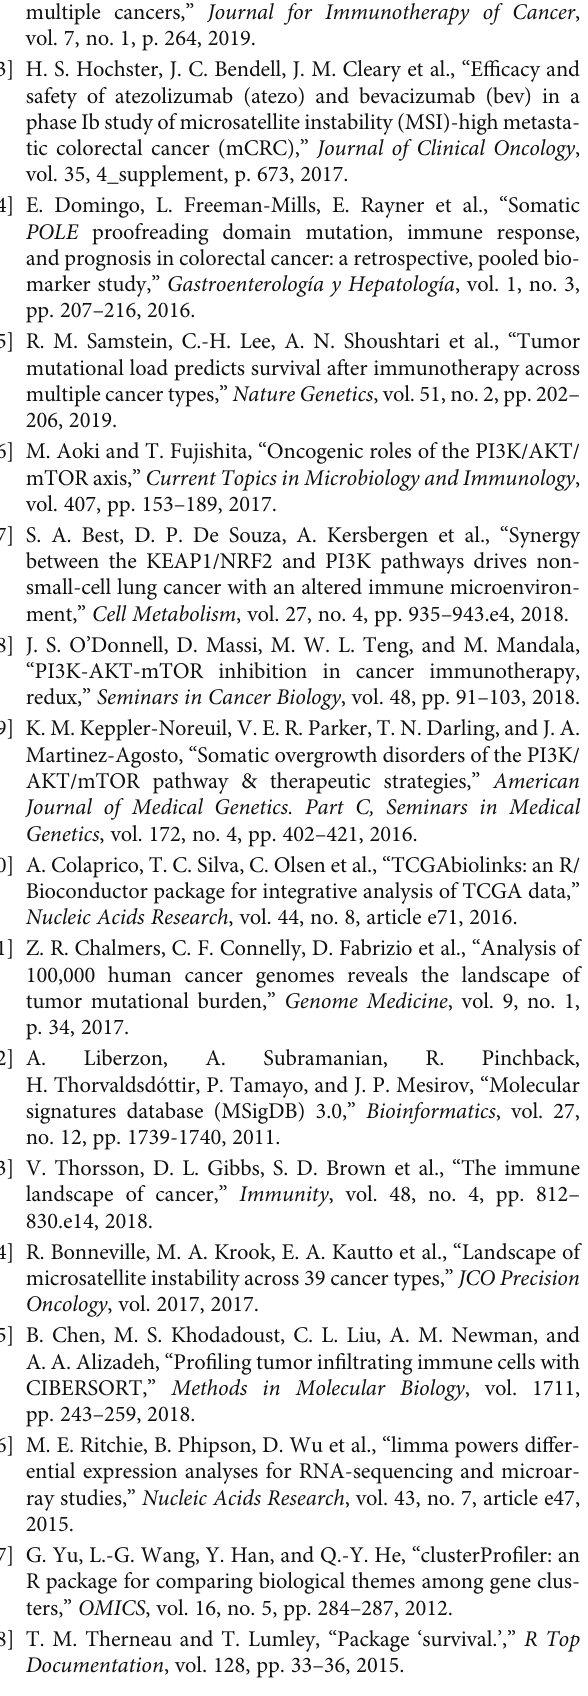
Supplementary Figure 1: mutual exclusion analysis of the top 20 mutant genes in the immunotherapy cohort (a) and TCGA cohort (b) ( ∗ P < 0 : 05 ; ∗∗ P < 0 : 01 ; ∗∗∗ P < 0 : 001 ; ∗∗∗∗ P < 0 : 0001 ; Fisher ’ s exact test). Table S1: the immunogenic characteristics of patients in Local-COAD. Table S2: the list of detected genes in targeted sequencing.